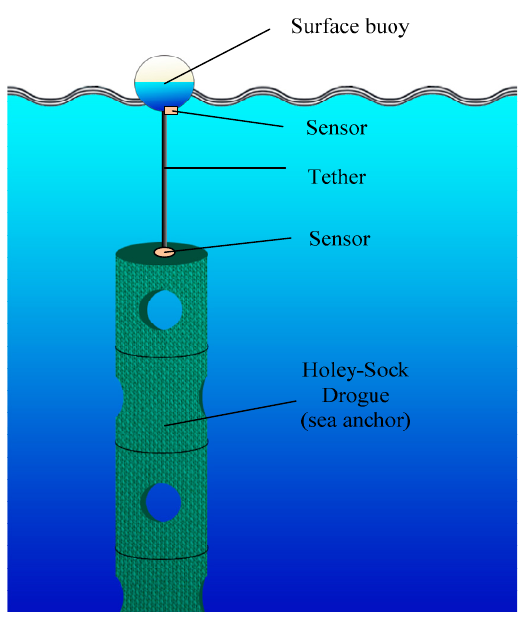
Figure 1. Structure of a drifter [4].